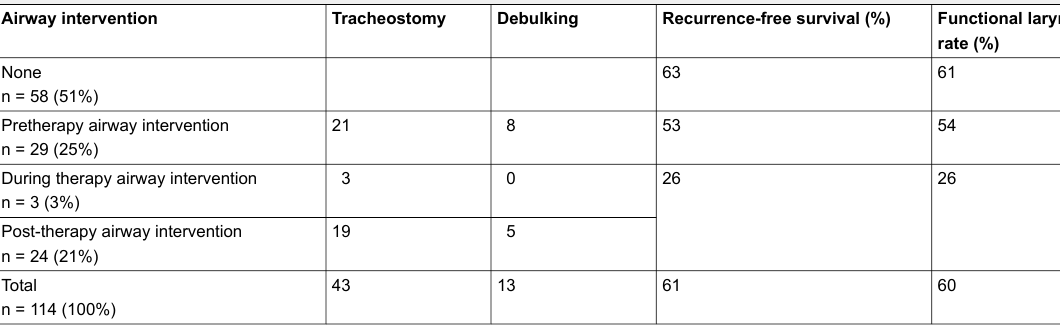
Table 2: Overview Any Recurrence free survival and functional larynx rate. Airway intervention